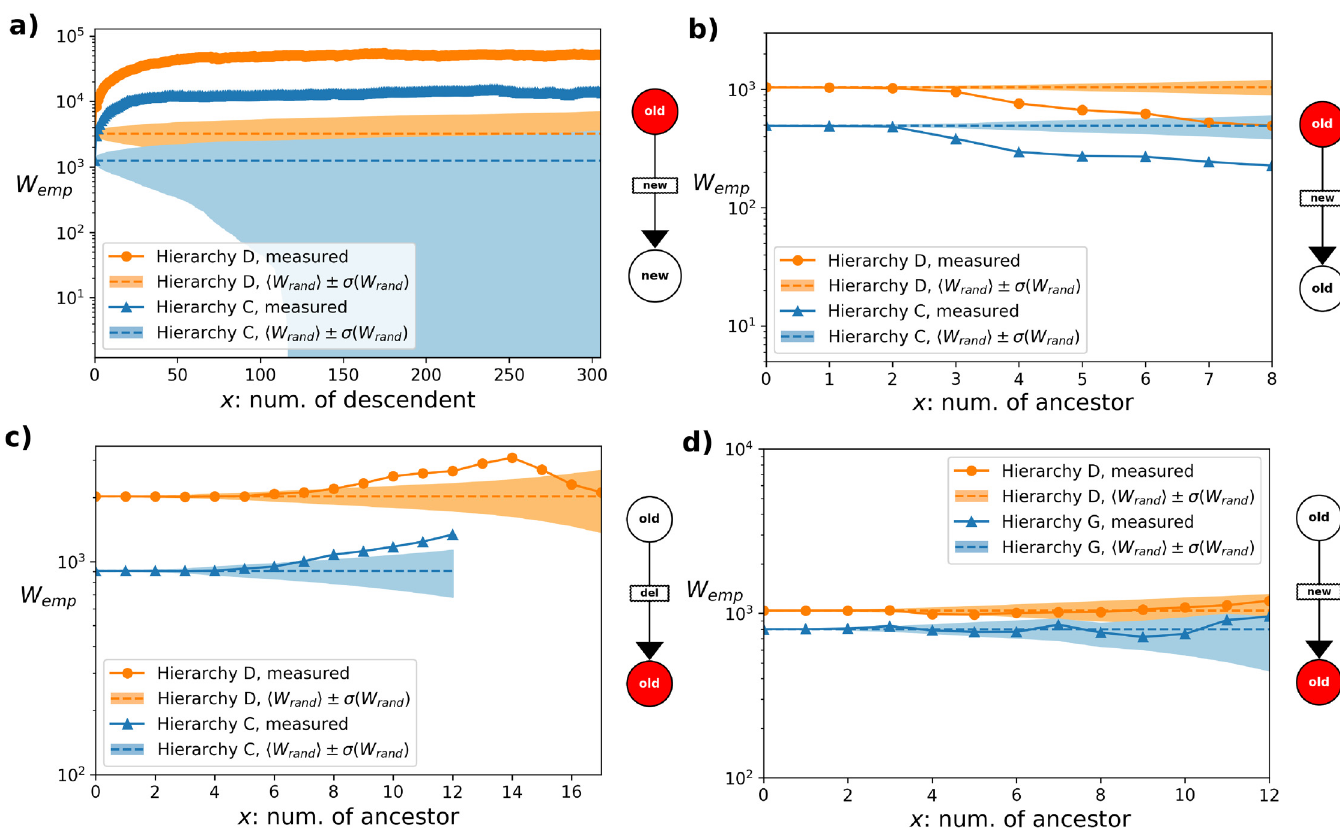
Fig 3. Measuring preference in attachment and detachment events. In each panel we compare W emp ( x ) defined in (8) to the mean and standard deviation of W ( x ) for random events, given in (9 and 10) and indicated by dashed lines in shaded areas. The pictograms beside the panels show the type of the studied attachment/detachment events and highlight in red whether the given property x was measured on the source or on the target of the links involved in the events. a) Results for the total number of descendants of source nodes in attachments of new links pointing from old nodes to new nodes in hierarchies D (orange) and C (blue). b) W emp ( x ) for the number of ancestors of source nodes on new links appearing between old nodes, measured in hierarchies D (orange) and C (blue). c) The same plots when x is equal to the number of ancestors of the target nodes in link deletion events for hierarchies D (orange) and C (blue). d) W emp ( x ) in case x is corresponding to the number of ancestors of the target node in attachment of new links between old